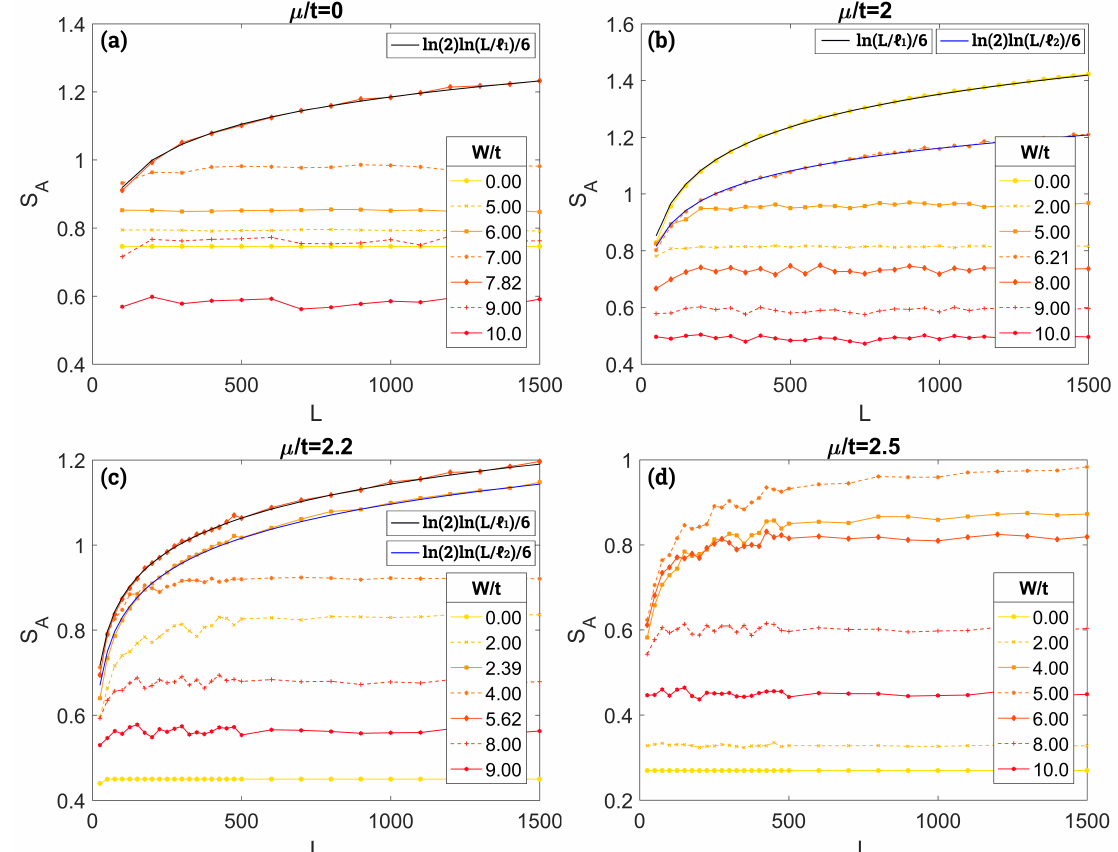
Figure 2. von Neumann entanglement entropy (disorder-averaged over 10 4 samples when W > 0) as a function of the total system size L for L A / L = 1/2, ∆ / t = 0.6, and periodic boundary conditions, for different values of the disorder strength W / t . Different panels correspond to different chemical potential: ( a ) µ / t = 0; ( b ) µ / t = 2; ( c ) µ / t = 2.2; ( d ) µ / t = 2.5. Black and blue curves indicate fits to a logarithmic critical behavior, as in Equation